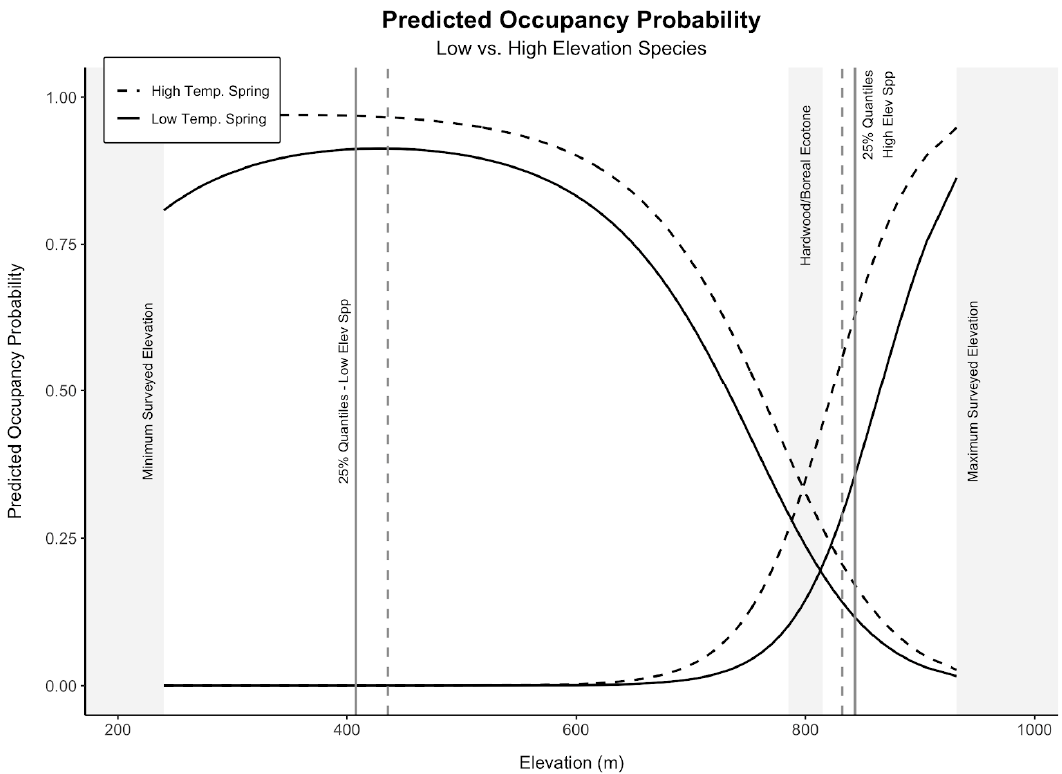
Figure 2. The simulated occupancy probabilities of high- and low-elevation species occupying a given elevation within HBEF, New Hampshire in relation to varying mean spring temperatures based on survey data corrected for imperfect detection. The solid lines represent species occupancy in a year with low spring temperatures, and the dashed lines represent occupancy in a year with high spring temperatures. The quantiles show how species distribution changes within their yearly range with mean spring temperatures.